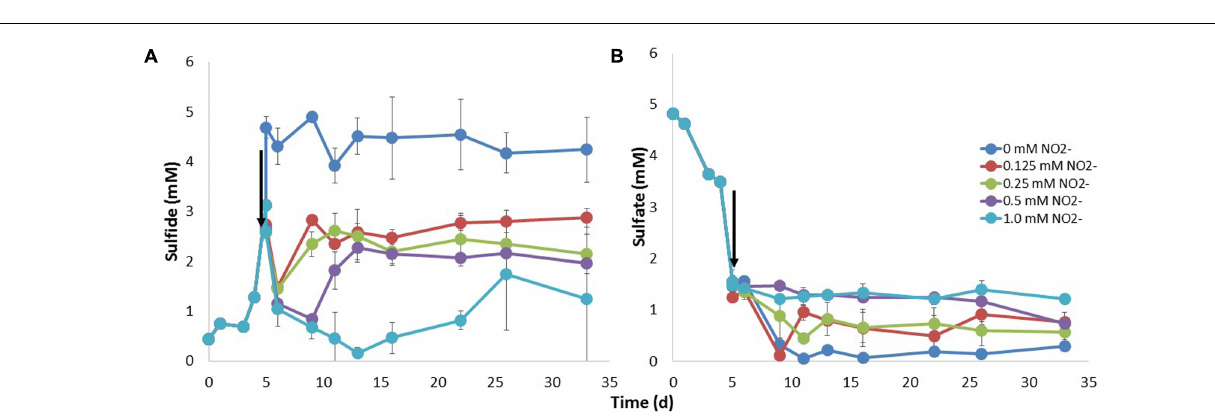
FIGURE 6 | Inhibition of sulfate reduction by tSRB with nitrite. A tSRB consortium enriched at 60 ◦ C ( Figure 5 ) was grown at this same temperature in medium with 20 mM lactate and 10 mM sulfate. The concentrations of (A) sulfide and (B) sulfate are shown as a function of time. Nitrite was injected at midlog phase ( ↓ ) in concentrations as indicated.